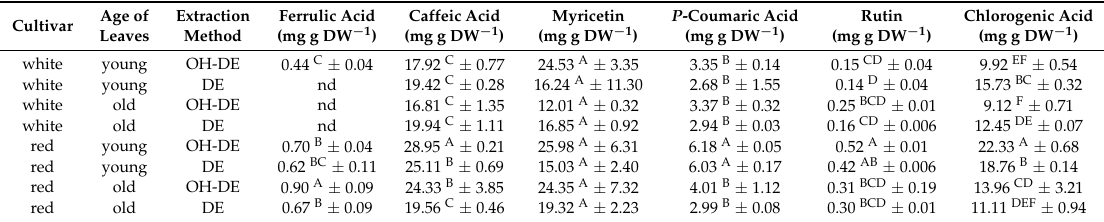
Table 6. Individual phenolic acid and flavonoid compounds of yacon leaves that were extracted with ohmic-assisted decoction (OH-DE) and decoction